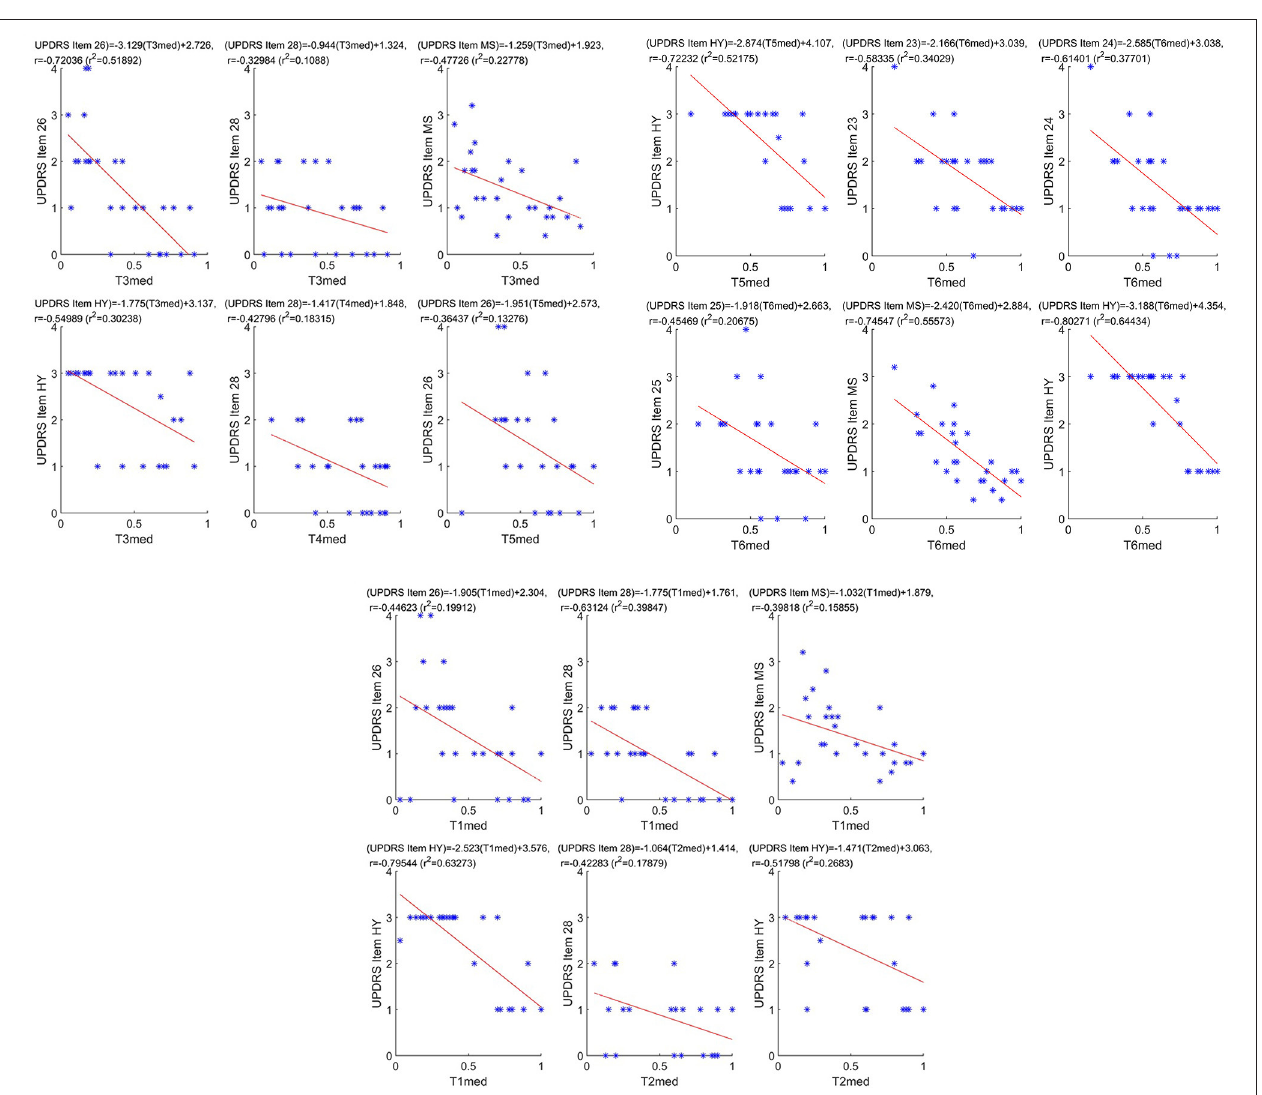
FIGURE 6 | Scatter plots of the Median FinalMotorScore values with all correlated pairs of the clinical feature set, i.e., ( T 1med: T 5 med, {26,28, MS, HY }) and ( T 6 med, {23,24,25, MS, HY }); the corresponding estimated r, ( r 2 ) and linear regression lines and equations are also superimposed on the scatter plots,